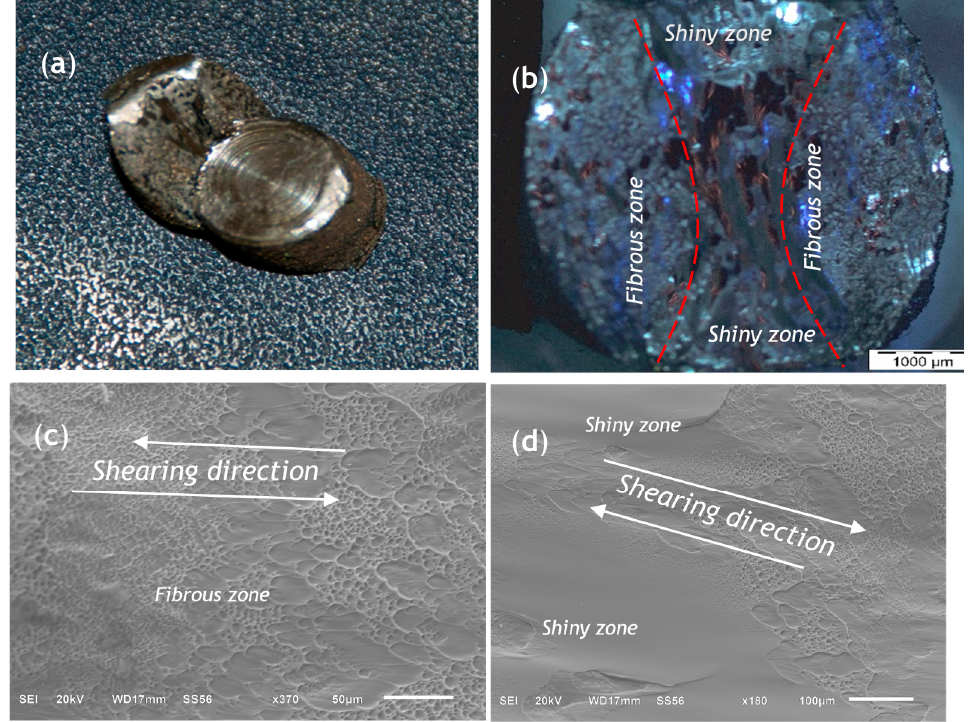
Figure 14. Typical photograph ( a ), optical micrograph ( b ) and secondary electron images ( c , d ) of the fracture surfaces of DMLS Ti6Al4V (ELI), showing fibrous and shiny zones.